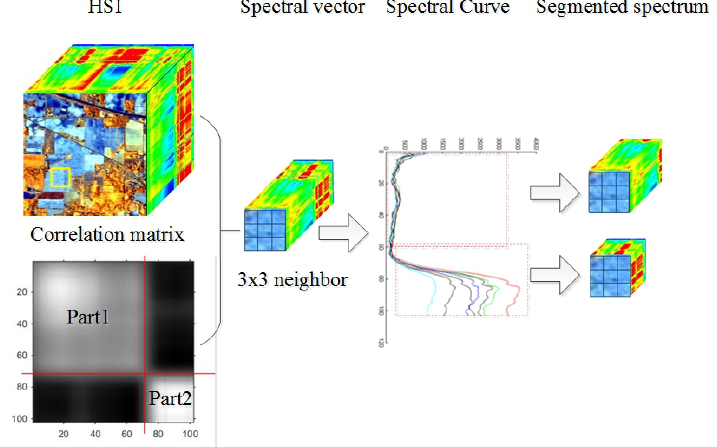
Figure 2. Spectral correlation analysis and band segmentation.